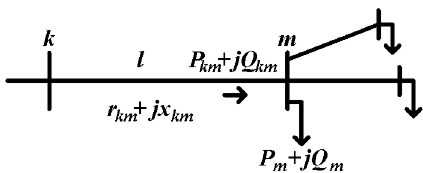
Figure 1. Sample distribution line. P km represents the sum of real power loads of all the nodes beyond node- m plus the real power load on node- m itself plus the sum of the real power losses of all the branches beyond node- m , Q km denotes the sum of reactive power loads of all the nodes beyond node- m plus the reactive power load on node- m itself, plus the sum of the reactive power losses of all the branches beyond node- m , r km − jx km represents the resistance and reactance of line- l , while P m + jQ m represents the real and reactive power load at node- m